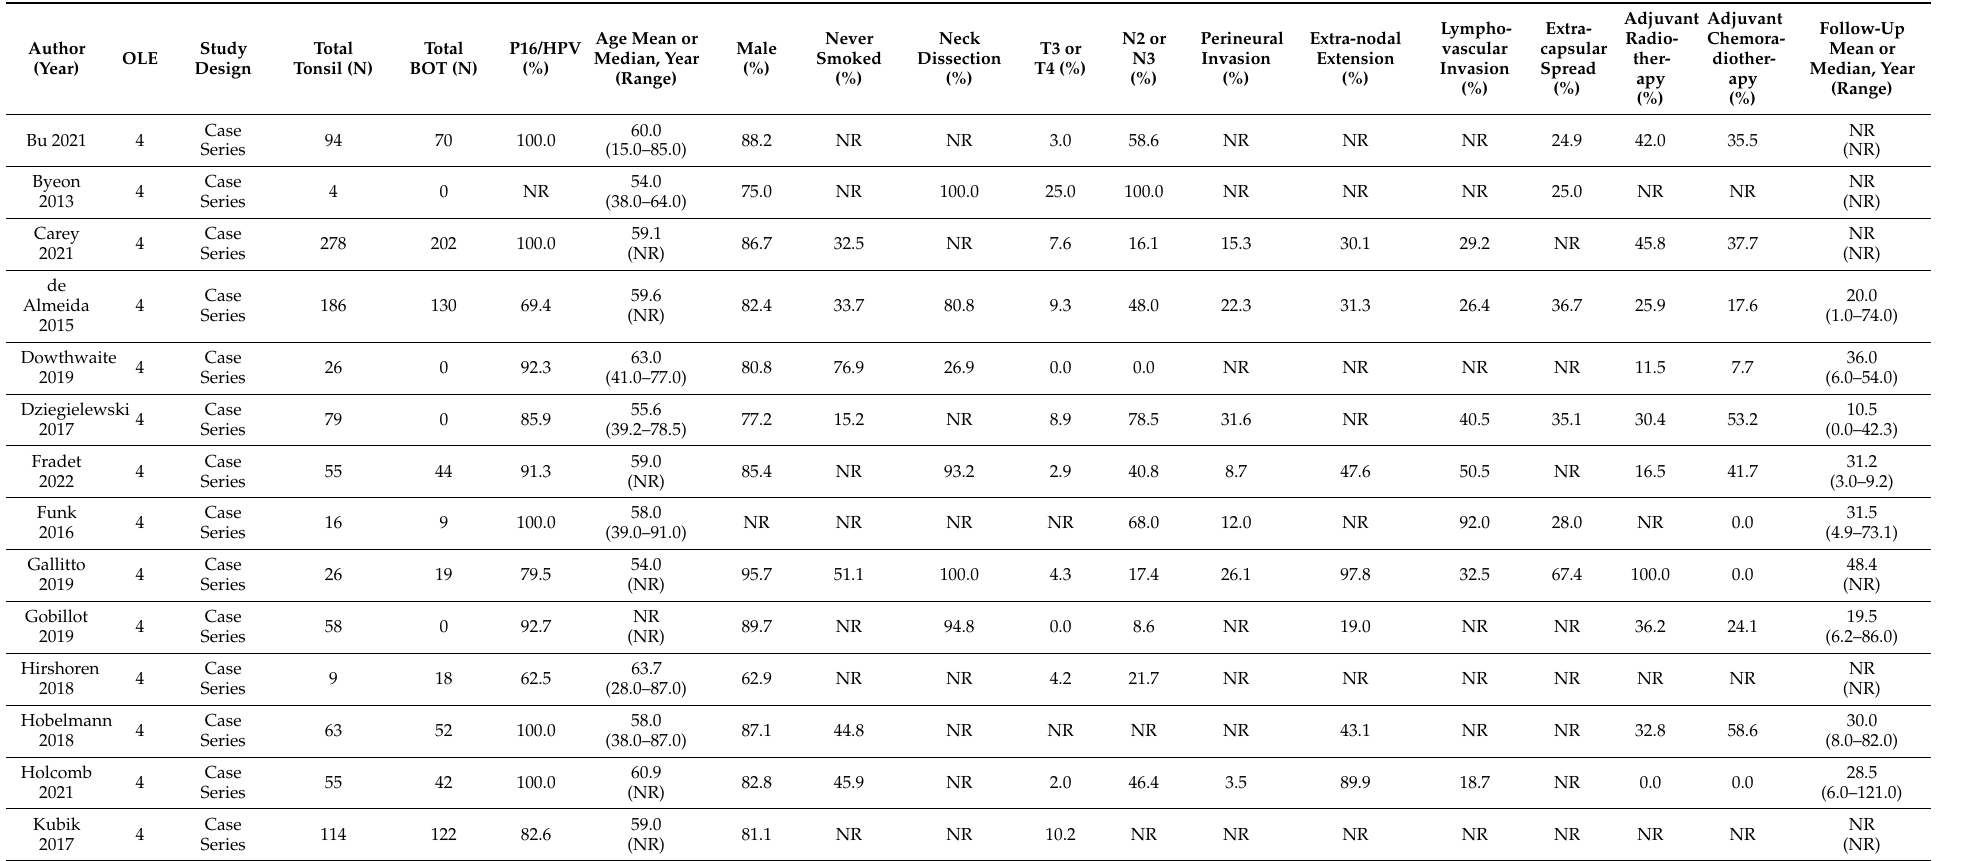
Table 1. Description of included